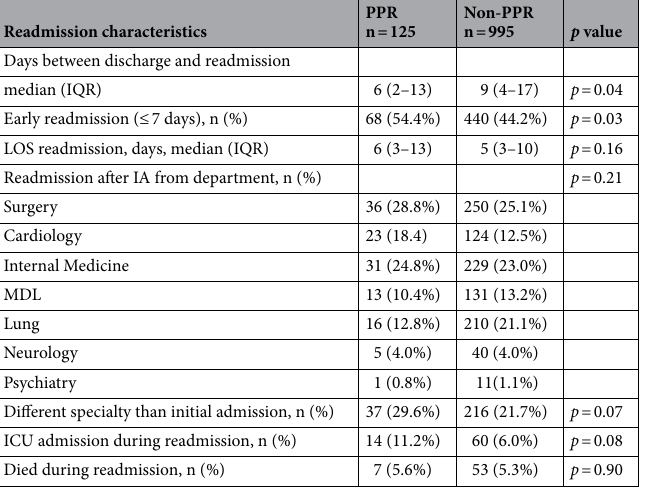
Table 2. Readmission characteristics of PPRs vs. non-PPRs. IA = initial admission, LOS = length of stay, PPR = potentially preventable readmissions. p values are adjusted for repeated patients in the cohort by means of GEE-analysis.